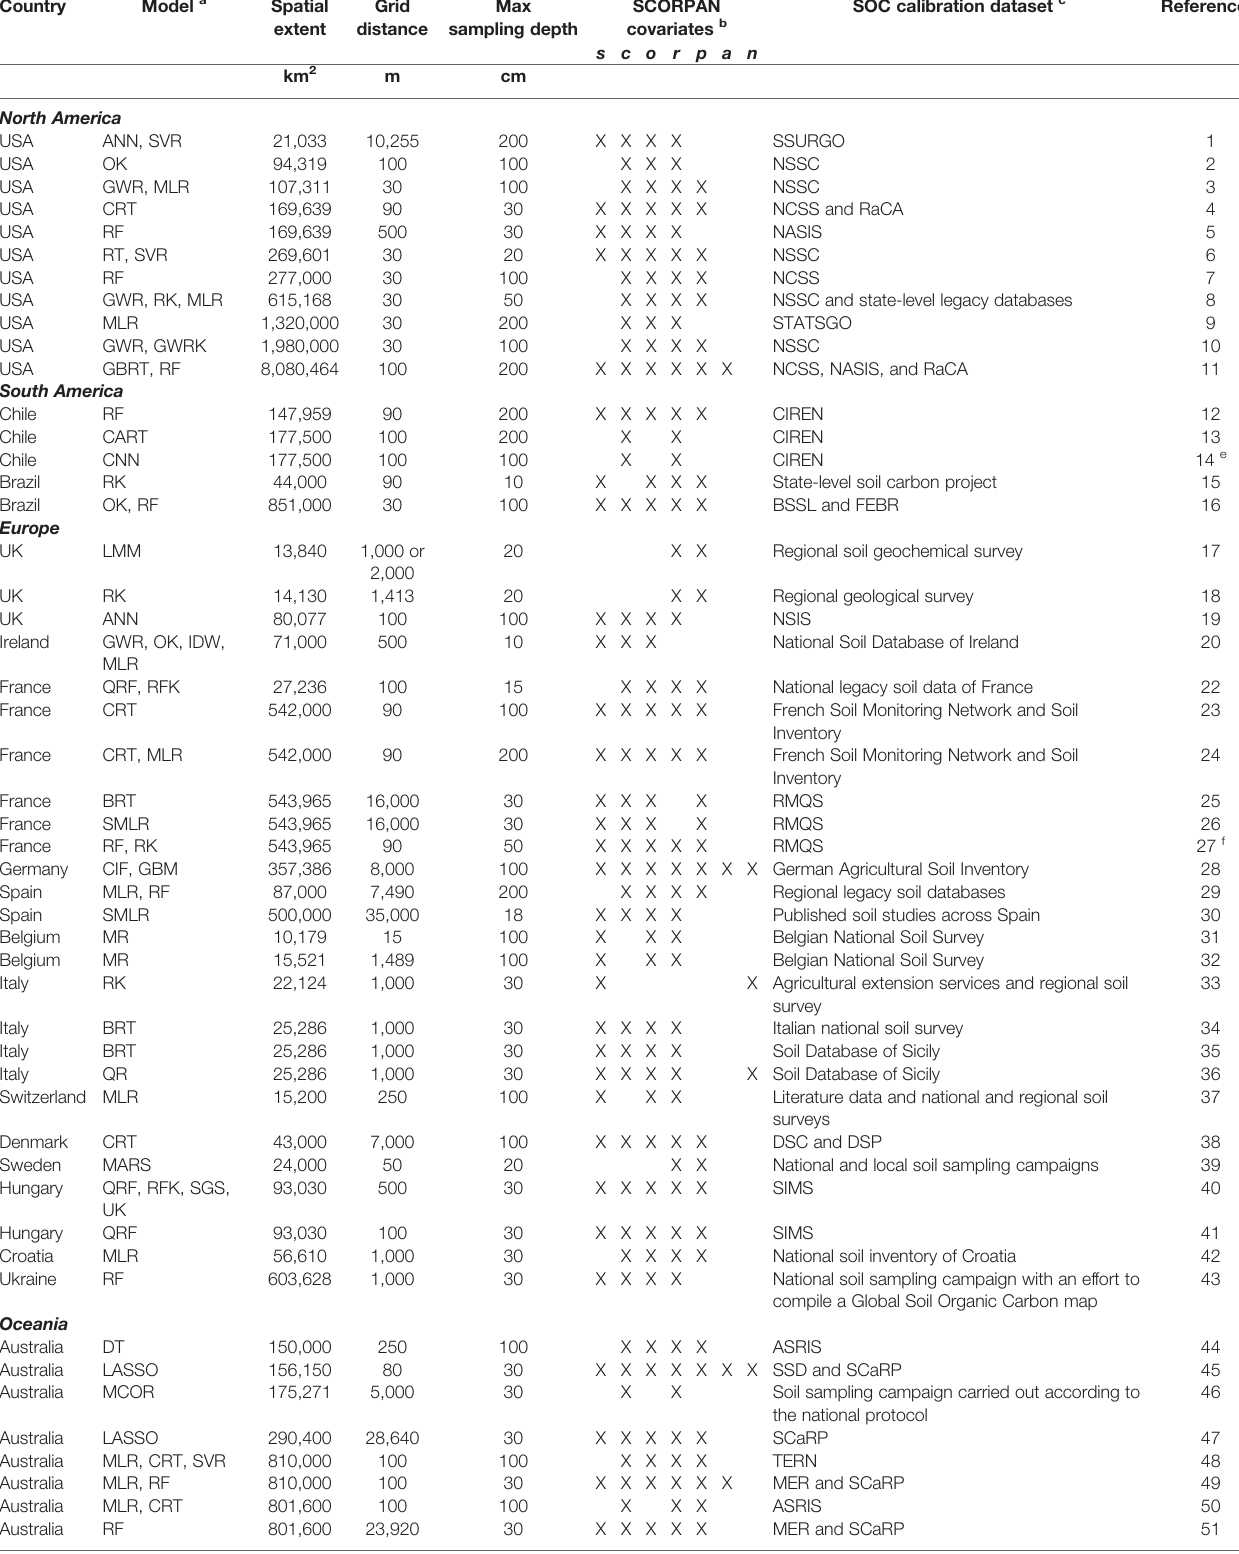
TABLE 1 | Regional and national SCORPAN-type studies quantifying soil organic carbon contents or stocks within agricultural lands.